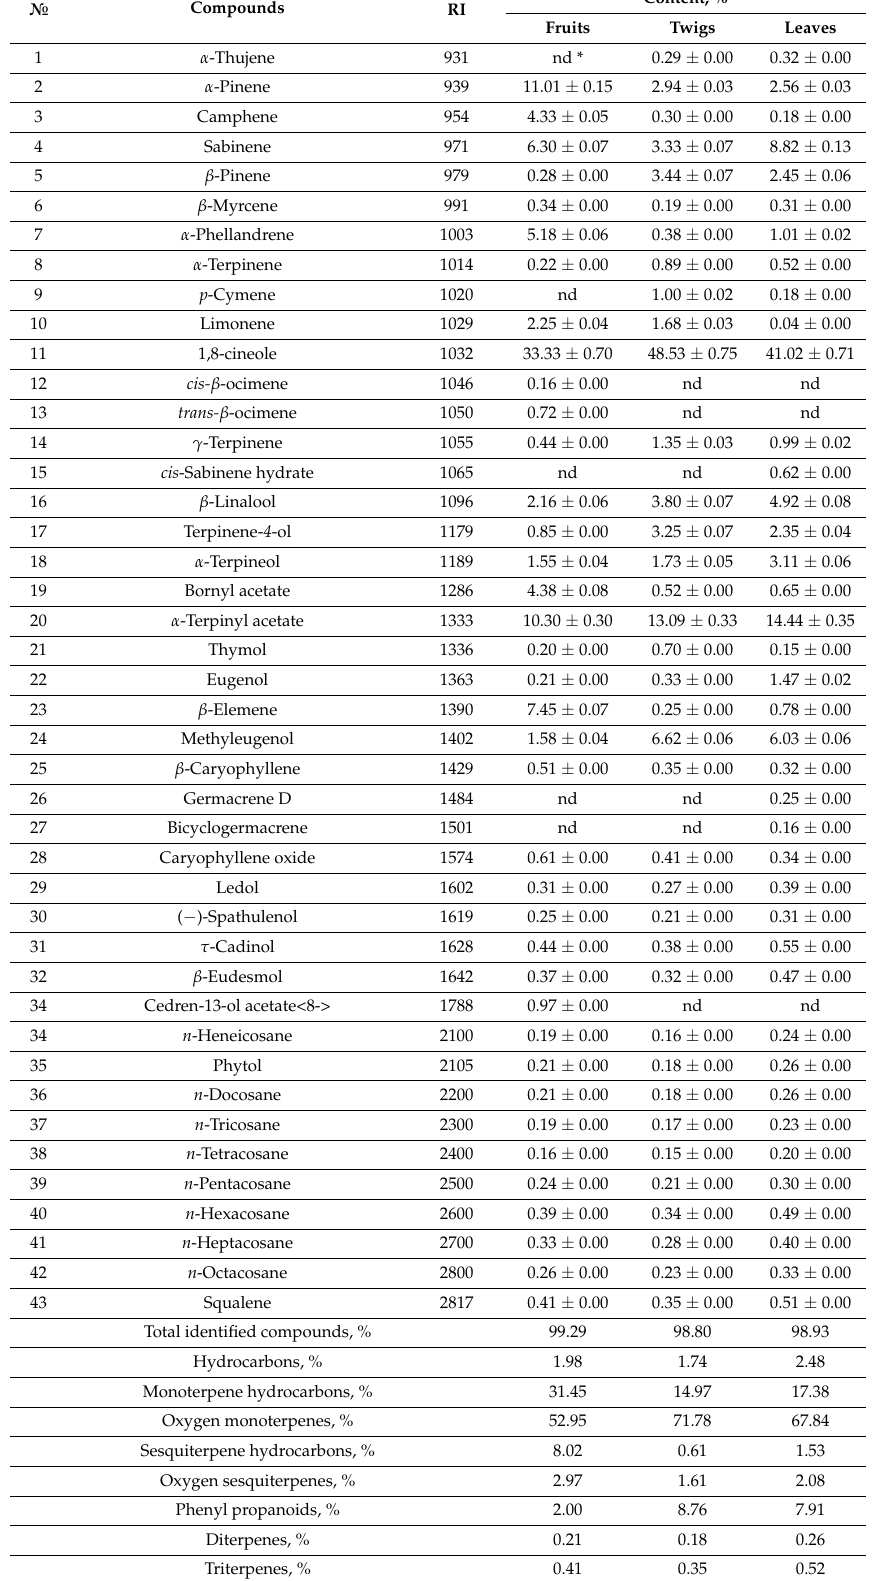
Table 1. Chemical composition of the laurel ( Laurus nobilis L.) fruits, twigs, and leaves essential oil.